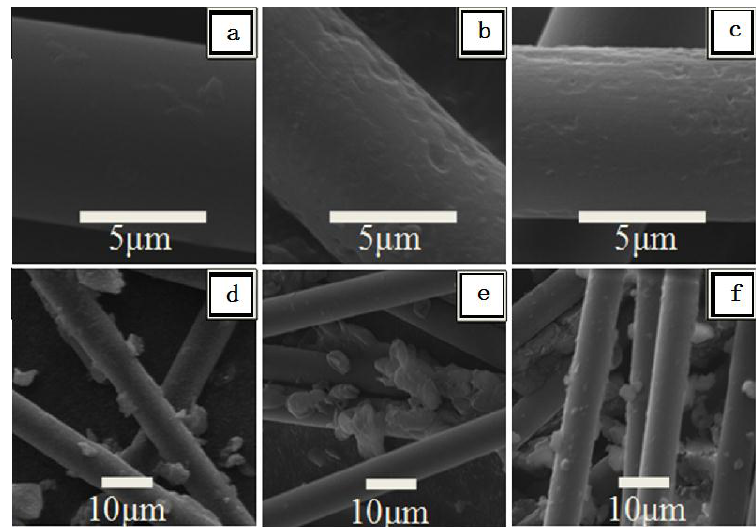
Figure 1. Scanning electron microscopy (SEM) images of carbon fibercarrier with raw and treated morphology and immobilized C. tropicalis ( a ) CF carrier without oxidation by nitric acid; ( b ) CF carrier after exposure to nitric acid treatment for 3 h; ( c ) CF carrier after exposure to nitric acid treatment for 6 h; ( d ) CF carrier without treatment immobilized with C. tropicalis ; ( e ) Immobilized C. tropicalis by CF carrier treated with nitric acid for 3 h; ( f ) Immobilized C. tropicalis by CF carrier treated with nitric acid for 6 h.